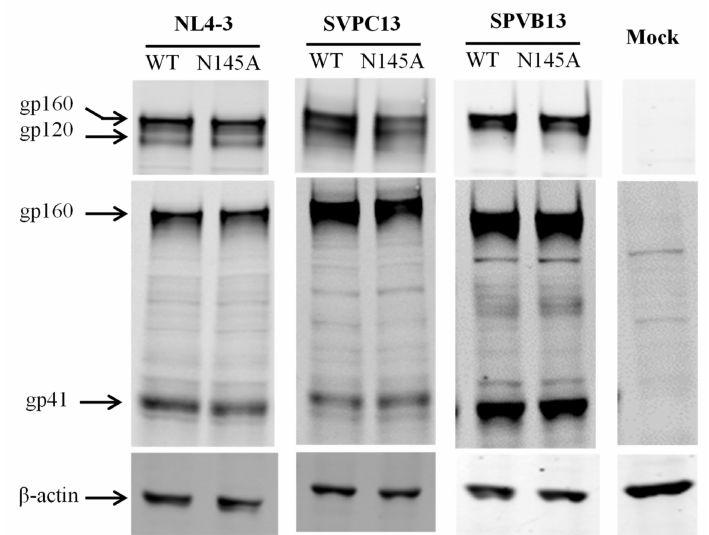
Figure 3. E ff ects of the N145A mutation on the expression of HIV-1 Env glycoprotein determined by Western blotting. The viral Env glycoproteins in the lysates of transfected cells were detected with a rabbit anti-gp120 polyclonal antibody (upper panel) and the human anti-gp41 monoclonal antibody 10E8 (middle panel). The reaction bands corresponding to gp160, gp120, and gp41 are marked. The experiments were repeated three times, and representative data are